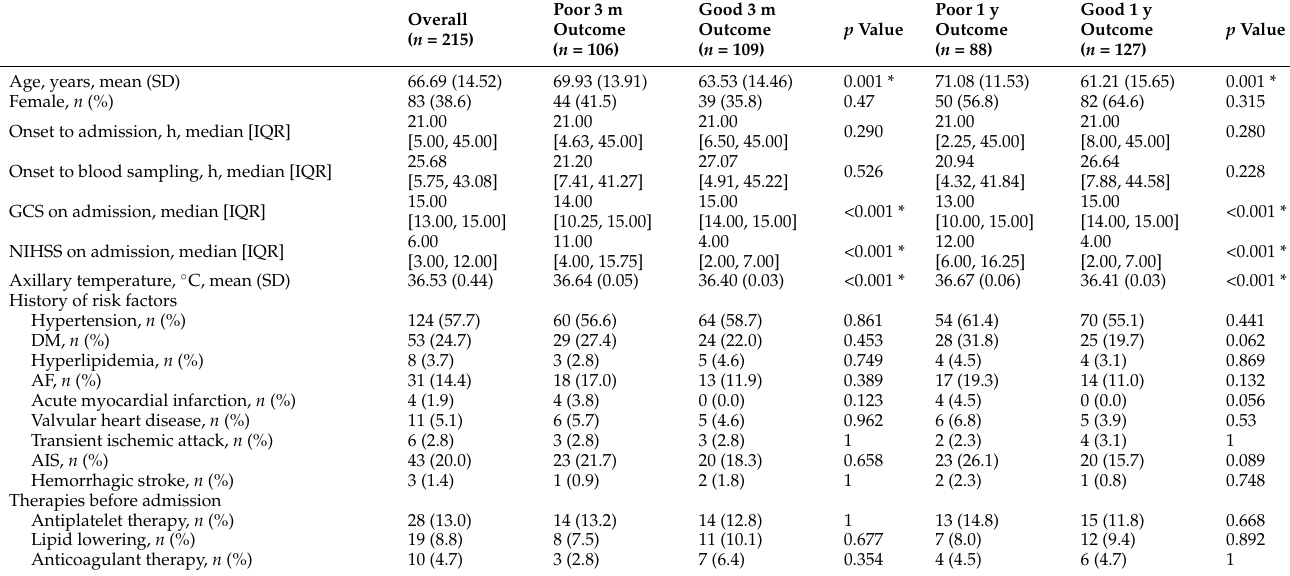
Table 1. The baseline characteristics of AIS patients with poor or good outcomes at 3 months and 1 year. Overall ( n =